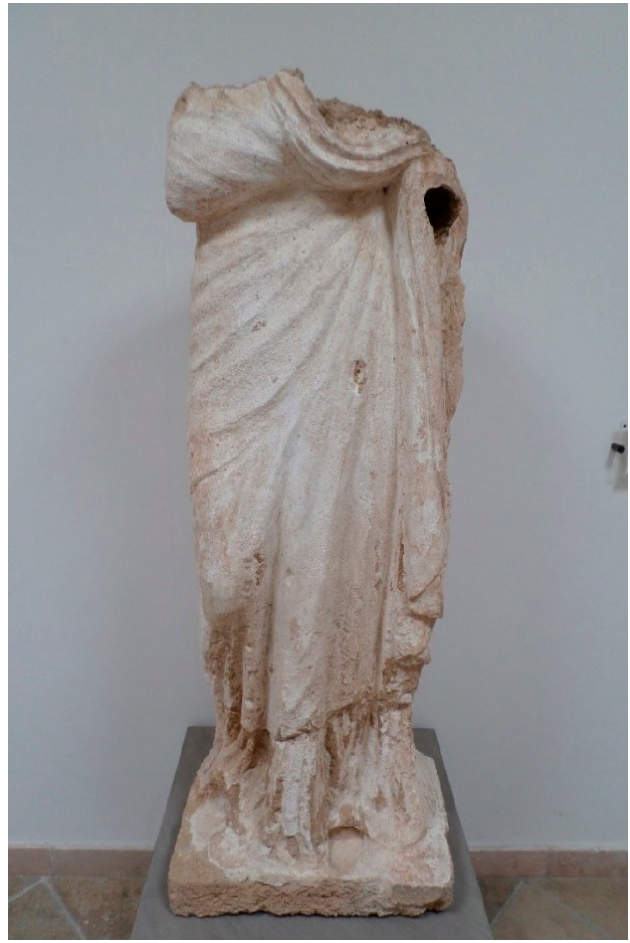
Figure 3. Soluntum, House of Leda, Limestone sculpture of a draped woman, now in the Soluntum Archaeological Museum (photo by the author).